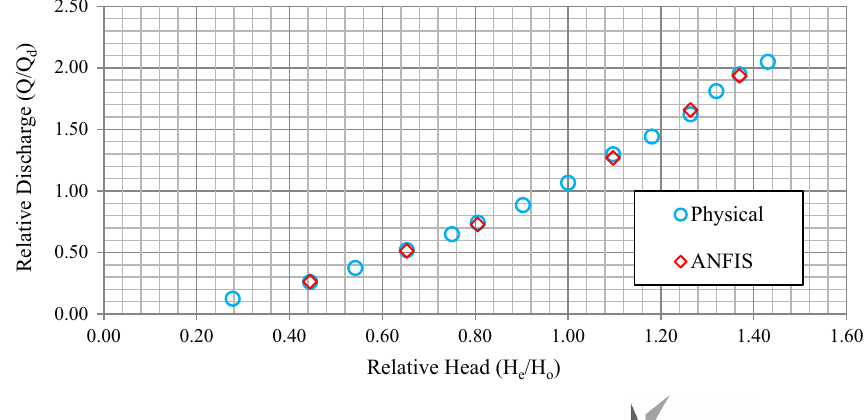
Fig. 17 Comparison of physical and